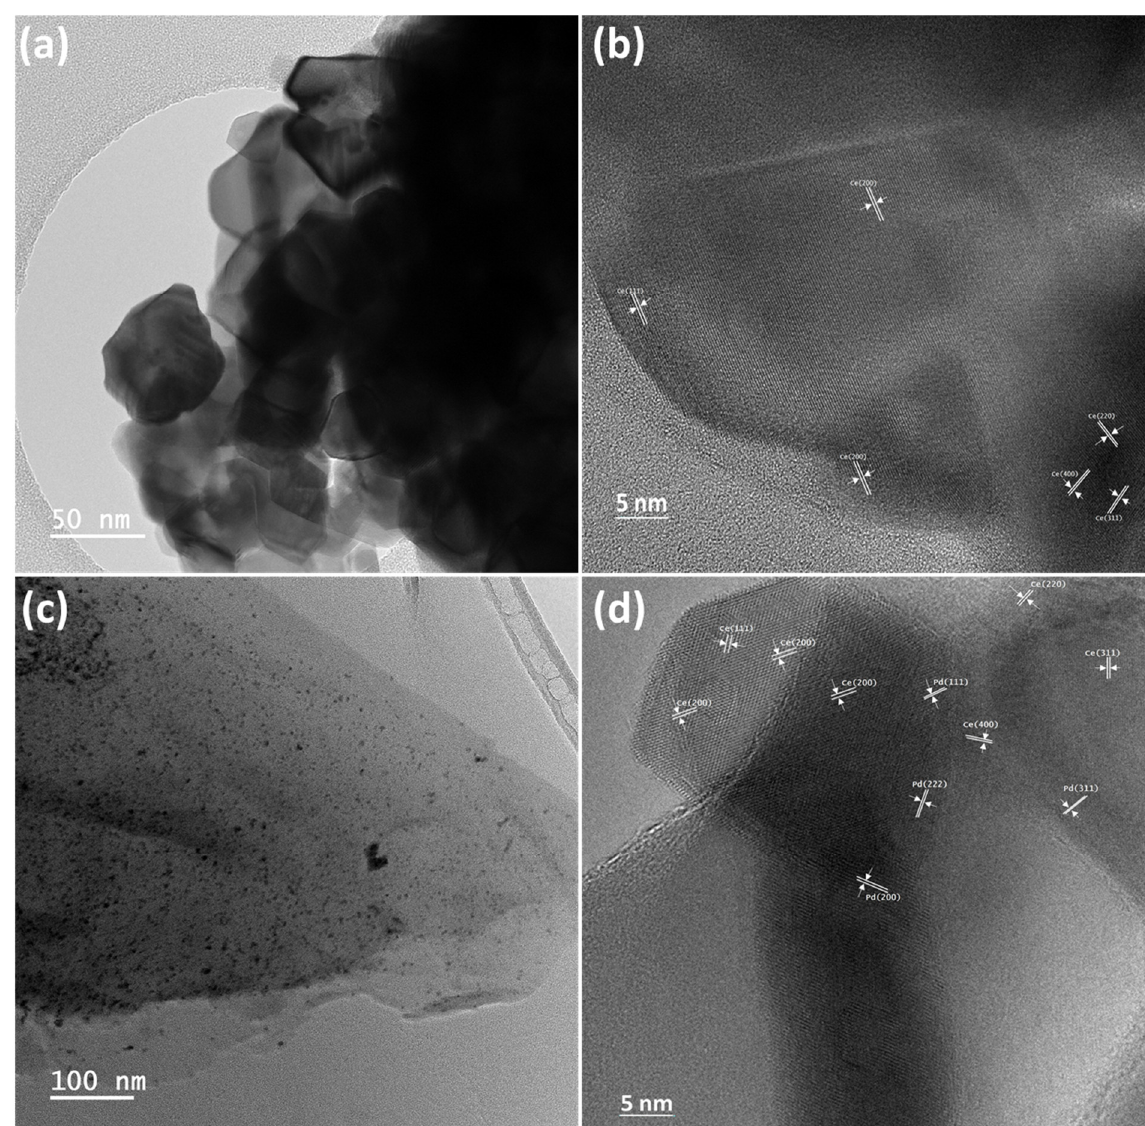
Figure 6. HRTEM images of the CeO 2 ( a , b ) and CeO 2 -Pd-PDA/rGO heterojunction nanocomposite ( c , d ) at low ( a , c ) and high ( b , d ) magnifications that indicate the interplanar spacings of 2D CeO 2 and Pd NPs.